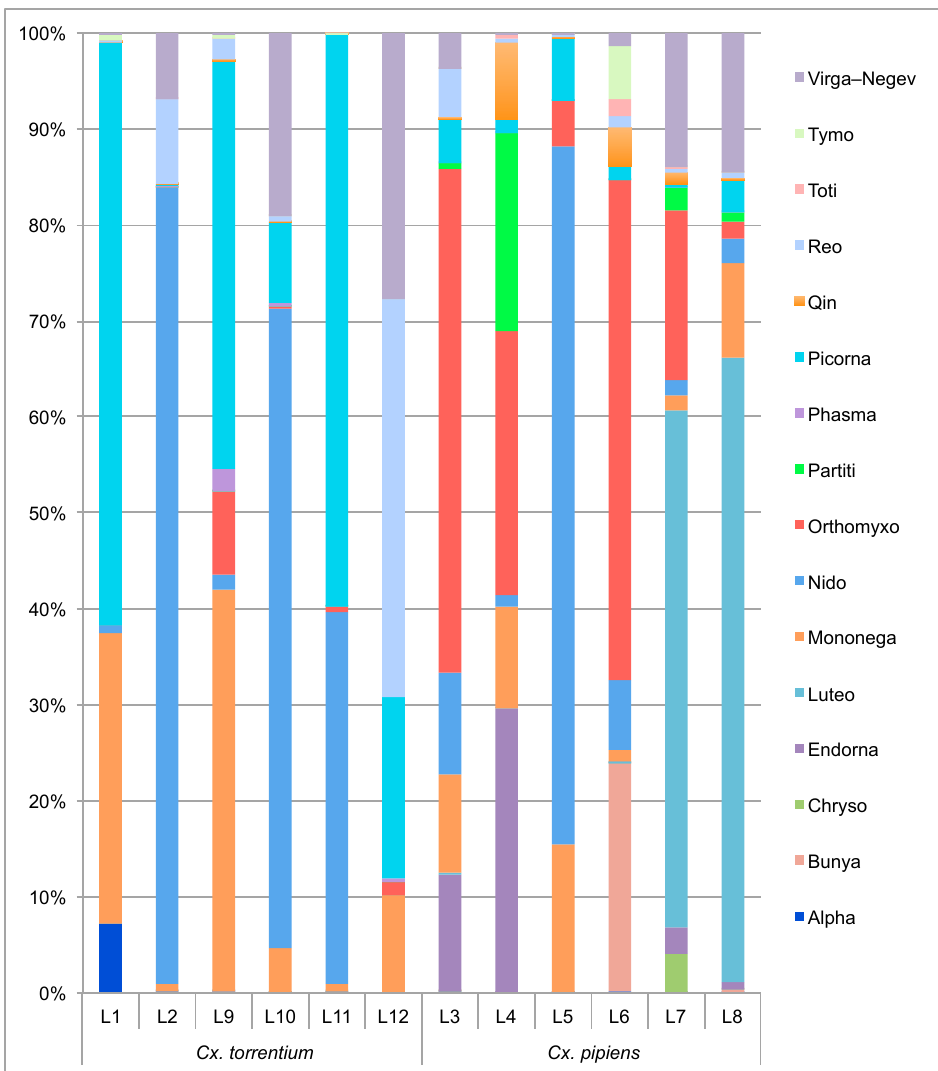
Figure 2. Comparison of the virome family composition and abundance between Cx. pipiens and Cx. torrentium . For ease of presentation, abbreviations are used to indicate virus taxonomy in each case. The viral families represented in each bar are shown according to the family order in the legend. Abbreviations: Alpha = Alphaviridae ; Bunya = Bunyaviridae ; Chryso = Chrysoviridae ; Endorna = Endornaviridae ; Luteo = Luteoviridae ; Mononega = Mononegavirales; Nido = Nido-like viruses; Orthomyxo = Orthomyxovirales; Partiti = Partitiviridae ; Phasma = Phasmavirus ( Bunyaviridae ); Picorna = Picornaviridae ; Qin = Qin-like viruses; Reo = Reoviridae ; Toti = Totiviridae ; Tymo = Tymoviridae ; Virga–Negev = Virgaviridae and Negev-like